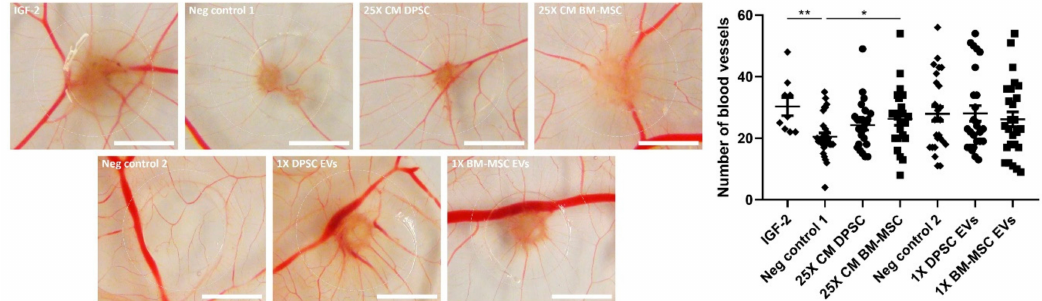
Figure 5. In ovo angiogenic e ff ect of CM and EVs derived from DPSCs and BM-MSCs. Plastic discs containing EVs ( n = 26 eggs) or 25X concentrated CM of DPSCs ( n = 24 eggs) and BM-MSCs ( n = 23 eggs) in Matrigel were placed on the chorioallantoic membrane (CAM) of chicken embryos at embryonic day 9. Concentrated ( n = 30 eggs) and standard ( n = 26 eggs) DMEM medium were used as negative controls 1, and 2, respectively, while 500 ng IGF-2 in 25X concentrated DMEM medium served as positive control ( n = 9 eggs). Three days later, the number of blood vessels intersecting a circle of radius 4 mm around the disc was manually counted. Only BM-MSCs could increase in ovo neovascularization in a paracrine way, which was not induced by their EVs. Scale bars represent 4 mm, and data